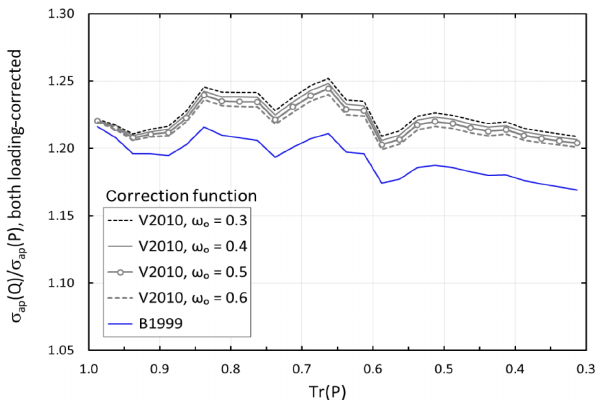
Figure 5. Average σ ap (quartz) /σ ap (Pallflex) in 0.025 bins of transmittance of Pallflex filter at λ = 530nm. σ ap (quartz) and σ ap (Pallflex) were corrected either according to Bond et al. (1999) with the Ogren (2010) modification (O2010) or to Virkkula (2010; V2010) using four values for the single-scattering albedo ω o